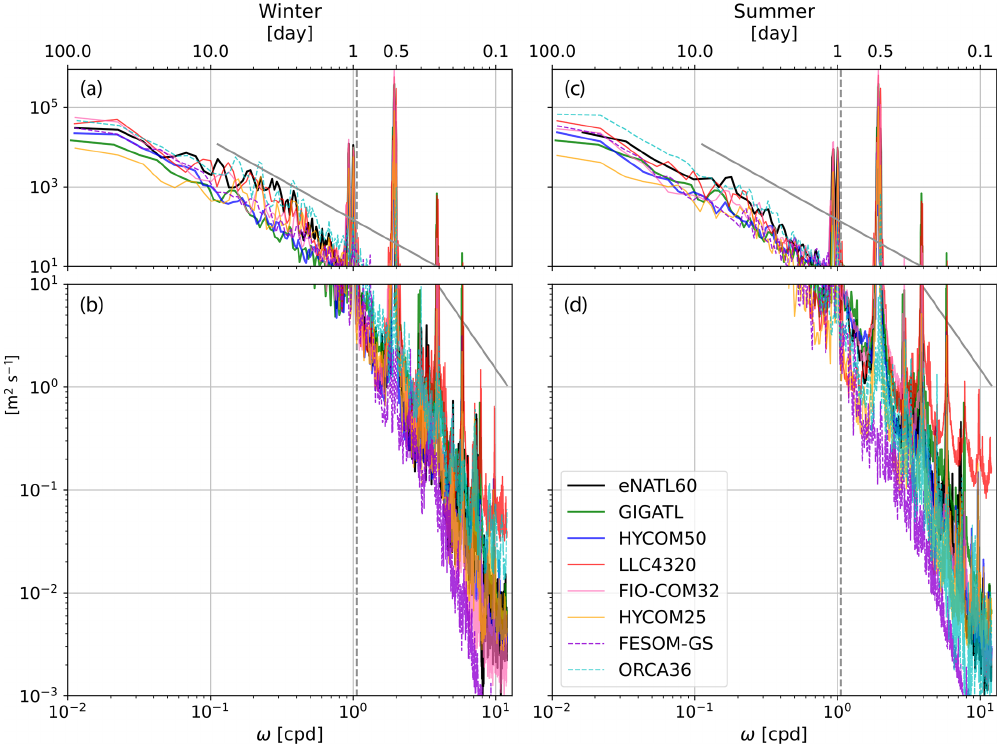
Figure 4. The frequency spectra of hourly SSH for winter (February, March, April; a, b ) and summer (August, September, October; c, d ). The panels are split up at 10m 2 s − 1 for visualization purposes. The frequency periodograms were computed every ∼ 10km in Region 1 and then spatially averaged. The runs without tidal forcing (FESOM-GS and ORCA36) are shown in dashed lines. The Garrett–Munk spectral slope of ω − 2 (Garrett and Munk, 1975) is shown as the grey solid line and the domain-averaged Coriolis frequency as the grey dashed